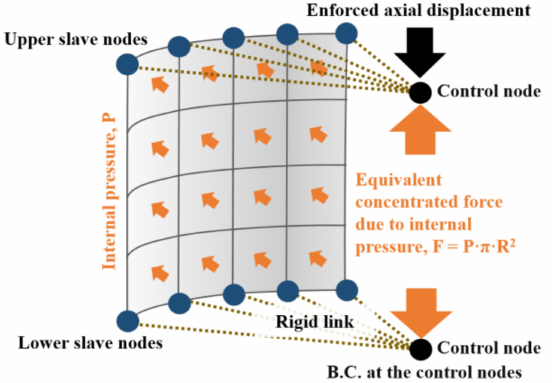
Figure 3. Applications of loads and boundary